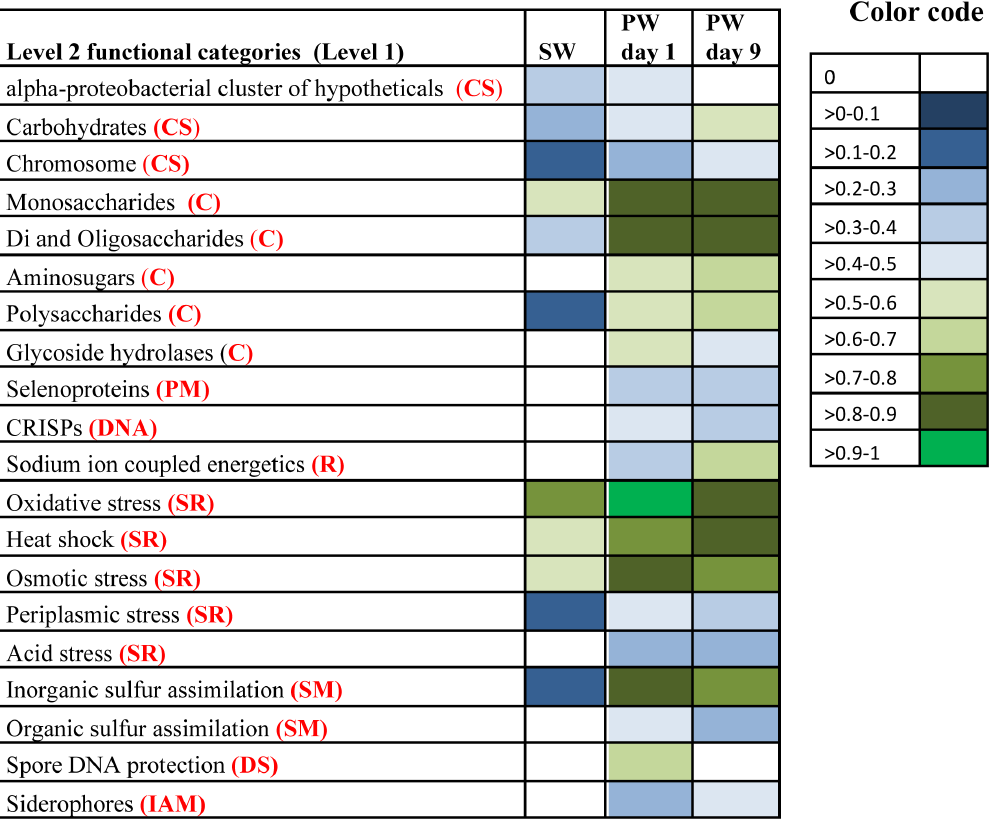
Figure 7. Normalized abundance (values of 0–1) of contigs belonging to selected Level 2 functional categories within associated Level 1 categories in source water (SW), produced water day 1 (PW day 1) and produced water day 9 (PW day 9). Functional annotations were assigned based on the Subsystems database. The affiliations of Level 2 categories to Level 1 categories are coded as follows CS- Clustering based subsystems; C- Carbohydrates; PM- Protein metabolism; DNA- DNA metabolism; R- Respiration; SR- Stress response; SM- Sulfur metabolism; DS- Dormancy and sporulation; IAM- Iron acquisition and metabolism.